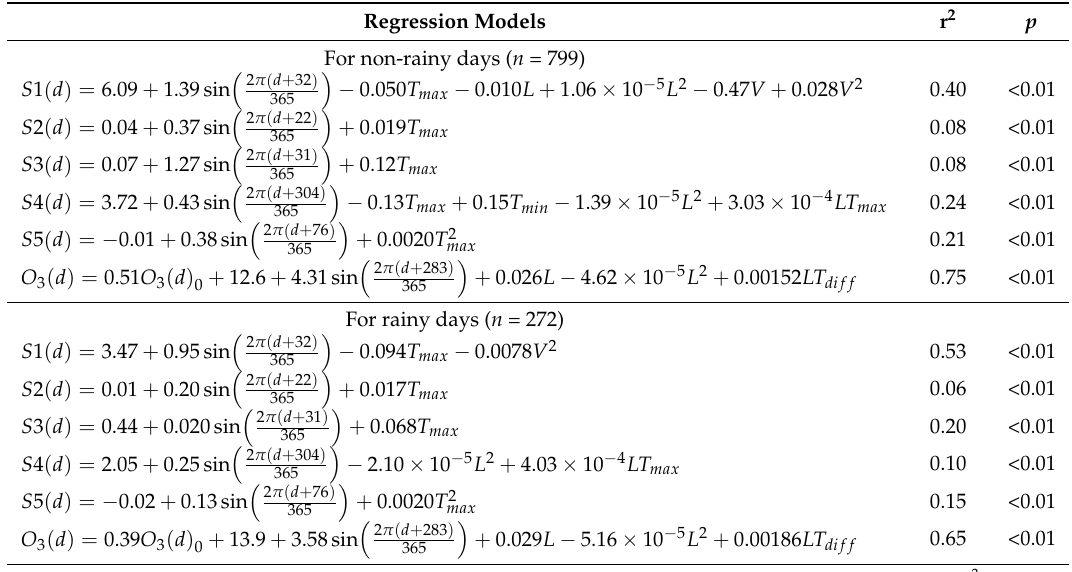
Table 2. Regression models using meteorological data as predictor variables. Regression Models r